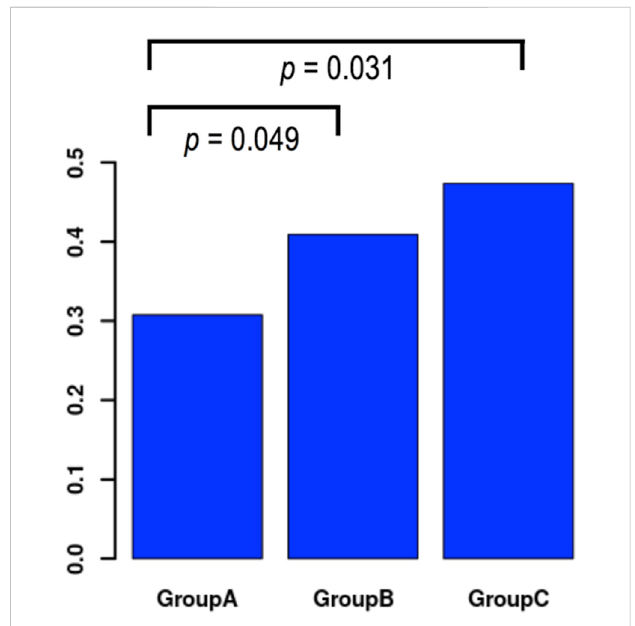
FIGURE 2 Distribution of pregnancy results in temporal groups and comparison of success rates across groups in univariate analysis. Group A: Vitri fi cation time 17:00 – 18:00 hpi, Group B: Vitri fi cation time